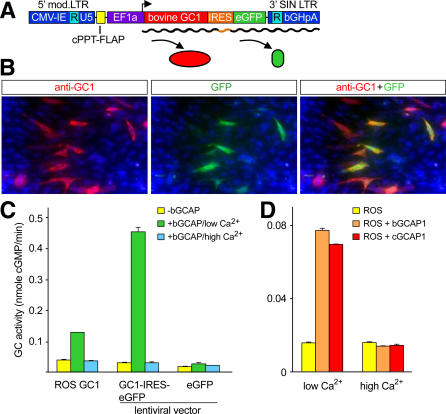
In Vitro Analyses of the Function of the pTYF-EF1α-GC1-IRES-eGFP Vector and Virus(A) Diagram of the bicistronic vector indicating production of bovine GC1 and GFP proteins from a single transcript.(B) DF1 cells transiently transfected with the vector and subsequently analyzed for expression of bovine GC1 and GFP. Cells immunostained with antibody recognizing bovine GC1 also expressed GFP.(C) Comparison of GC1 activity measured in bovine rod outer segments (ROS), TE671 cells transduced with EF1α-GC1-IRES-eGFP virus, and TE671 cells transduced with the control virus, EF1α-eGFP. Activity was assayed in the presence or absence of bovine GCAP1 under both high- and low-calcium conditions and is expressed as nanomoles of cGMP produced per minute.(D) Examination of ability of chicken GCAP1 to activate bovine GC1 under physiological conditions. GC1 activity was measured in preparations of bovine rod outer segments in the presence and absence of bovine GCAP1 and chicken GCAP1 under high- and low-calcium conditions. All assays were conducted in triplicate. Bars represent mean ± SEM.